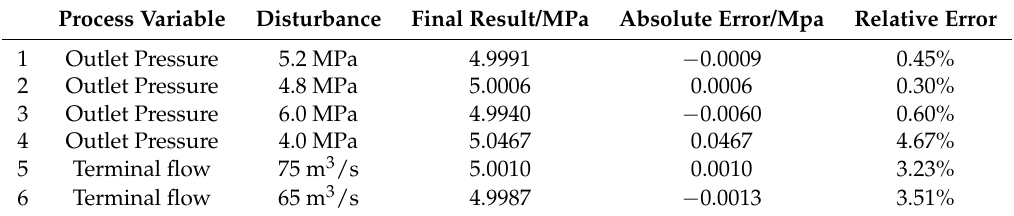
Table 2. The validation results of controller.